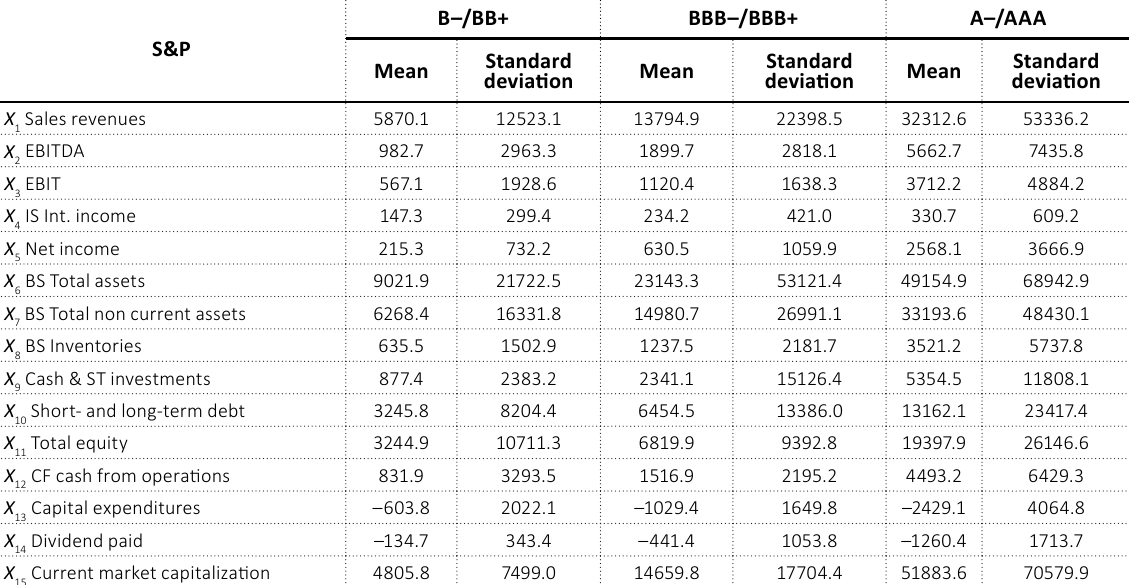
Table 13. Descriptive statistics for basic